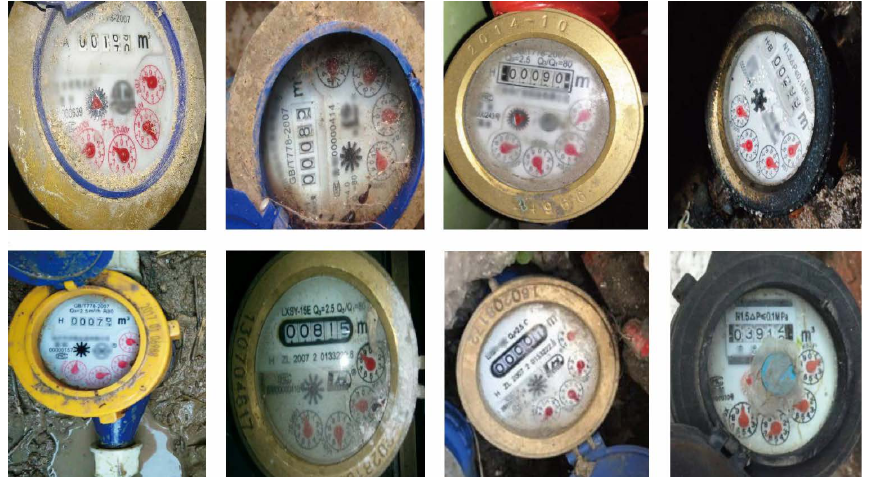
Figure 1. Watermeters under different challenging environments in real